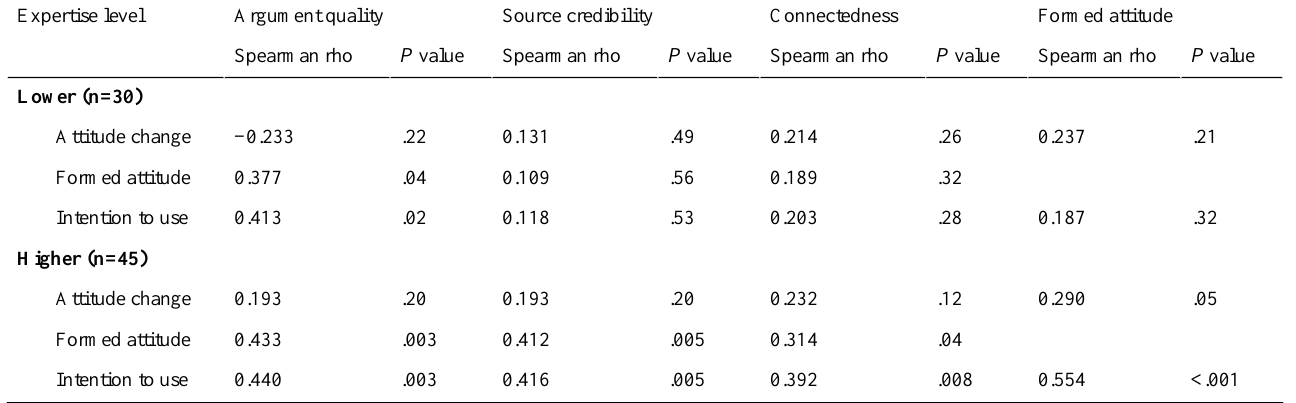
Table 3. Impact of persuasion routes on outcomes by expertise level